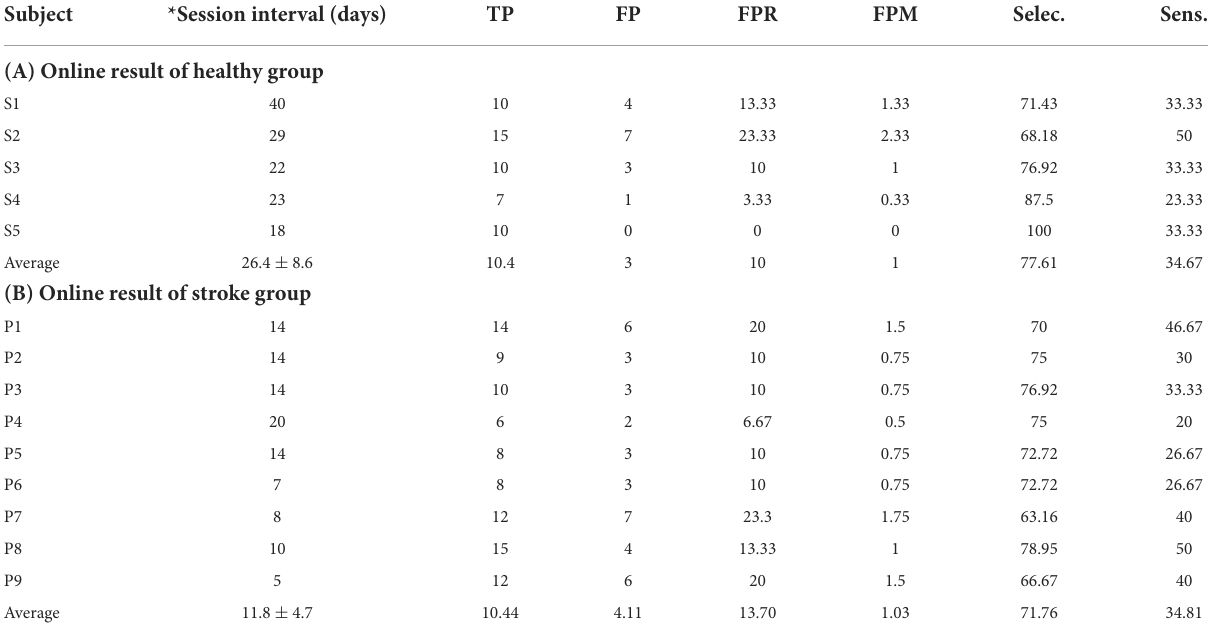
TABLE 2 Performance online MI-BCI (A) in the healthy group and (B) in the stroke patients’